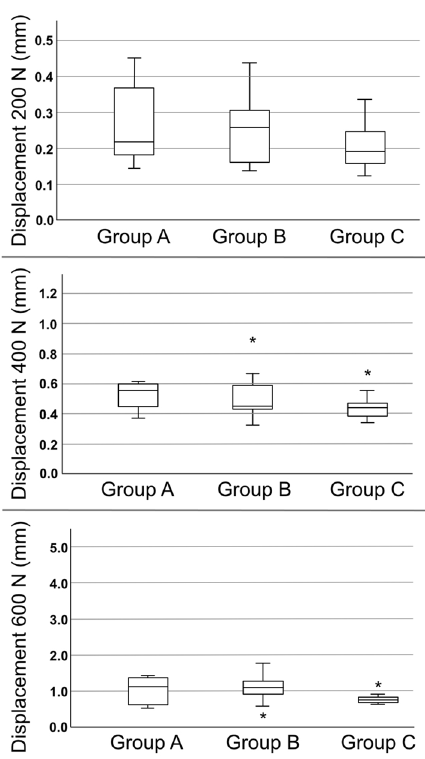
Figure 4. Peak-to-peak displacement of the different groups tested under 200-, 400- and 600-N Load. Displacement was measured for the whole pelvis. Displacement rises under increasing load. No implant failure was observed. Statistically significant differences were not detected between the groups (asterisk =